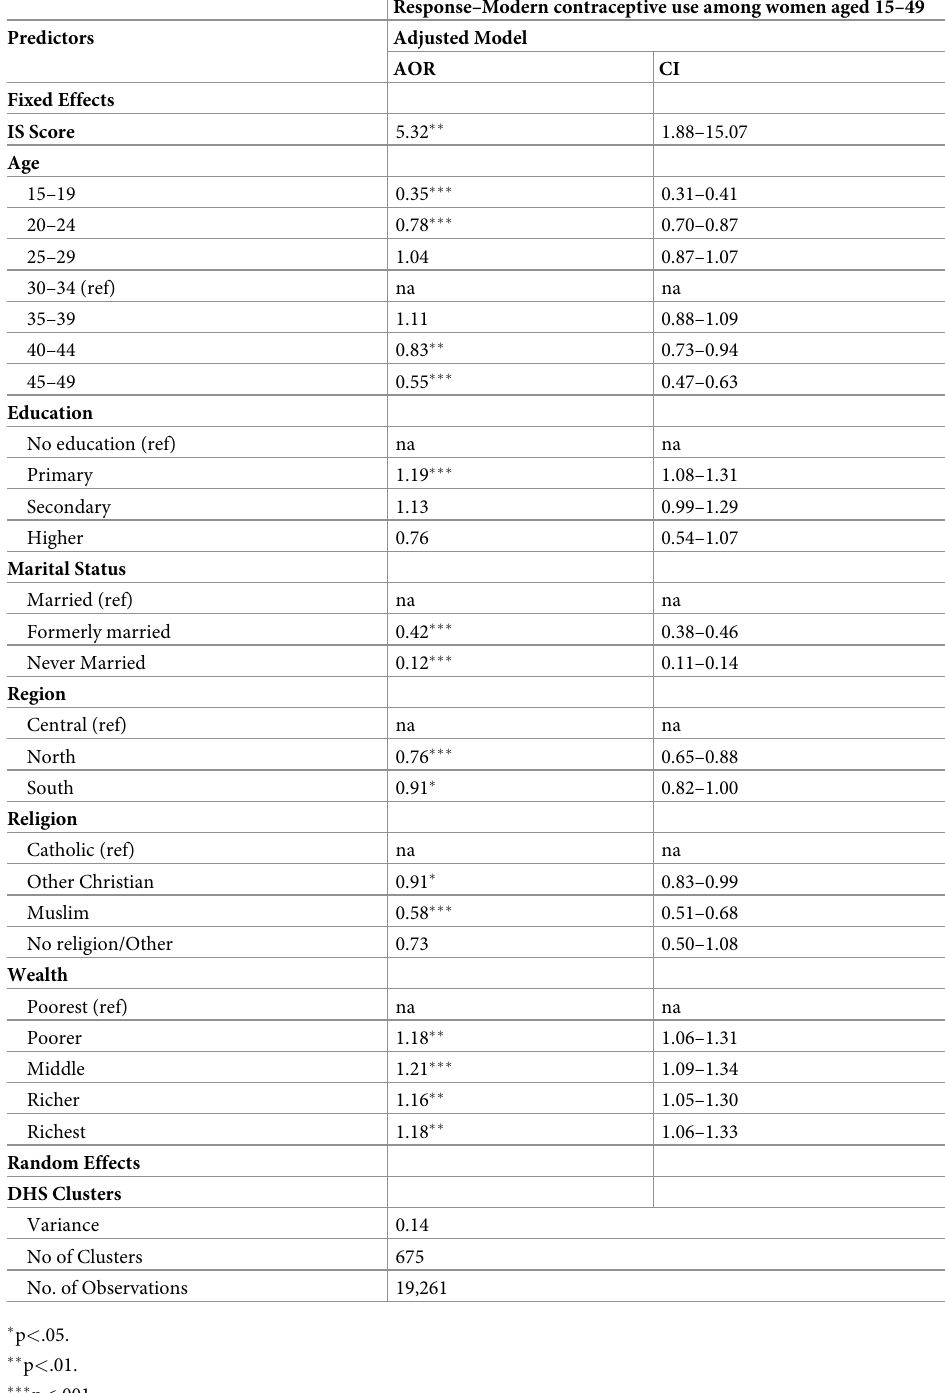
Table 4. Association between rural women’s use of modern contraceptives and implementation strength score, adjusted model with random